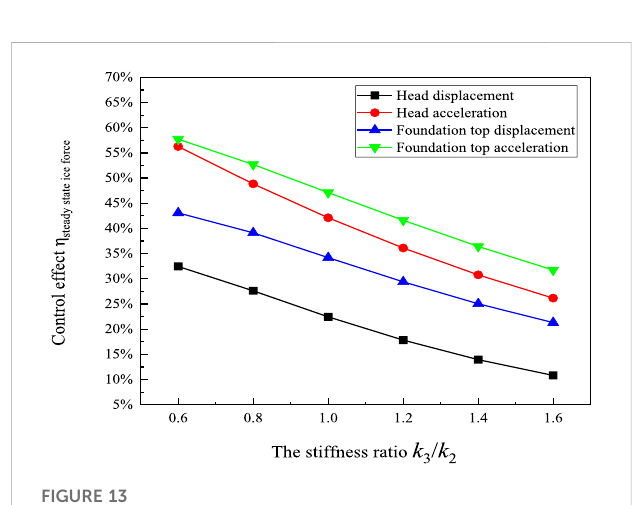
FIGURE 13 The control effectiveness of different stiffness ratios under random ice